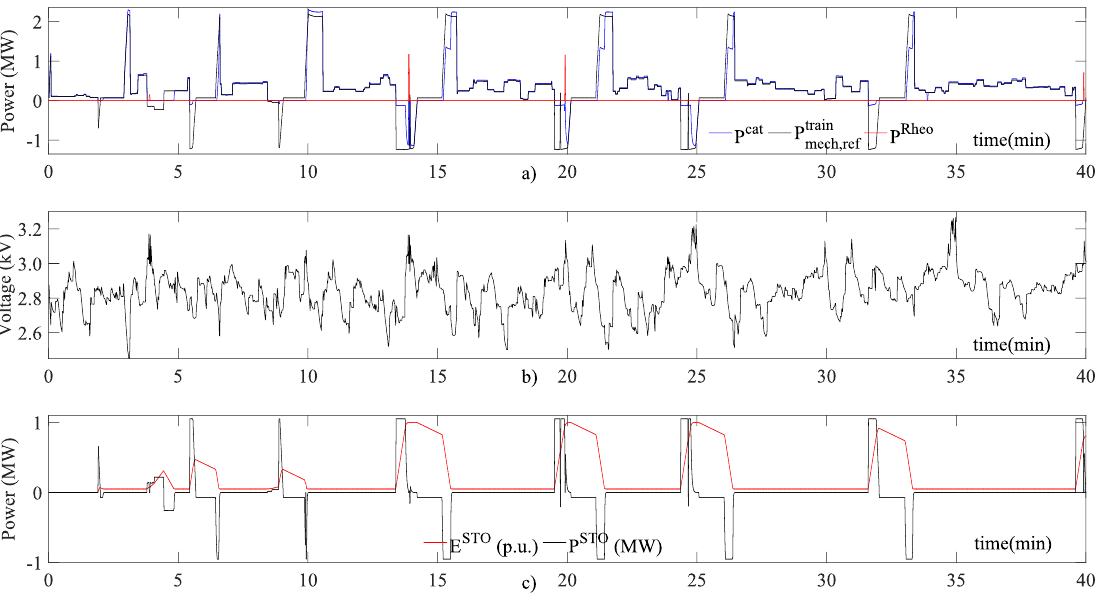
Figure 5. Detailed behavior of the fourth train on the blue line from S1 to S4 in the heavy traffic scenario with on-board energy storage. ( a ) Mechanical reference power; power extracted from the catenary and burned in the rheostatic system. ( b ) Catenary voltage. ( c ) Storage system power (in black) and state of charge of the energy storage system (in red) in (p.u.).